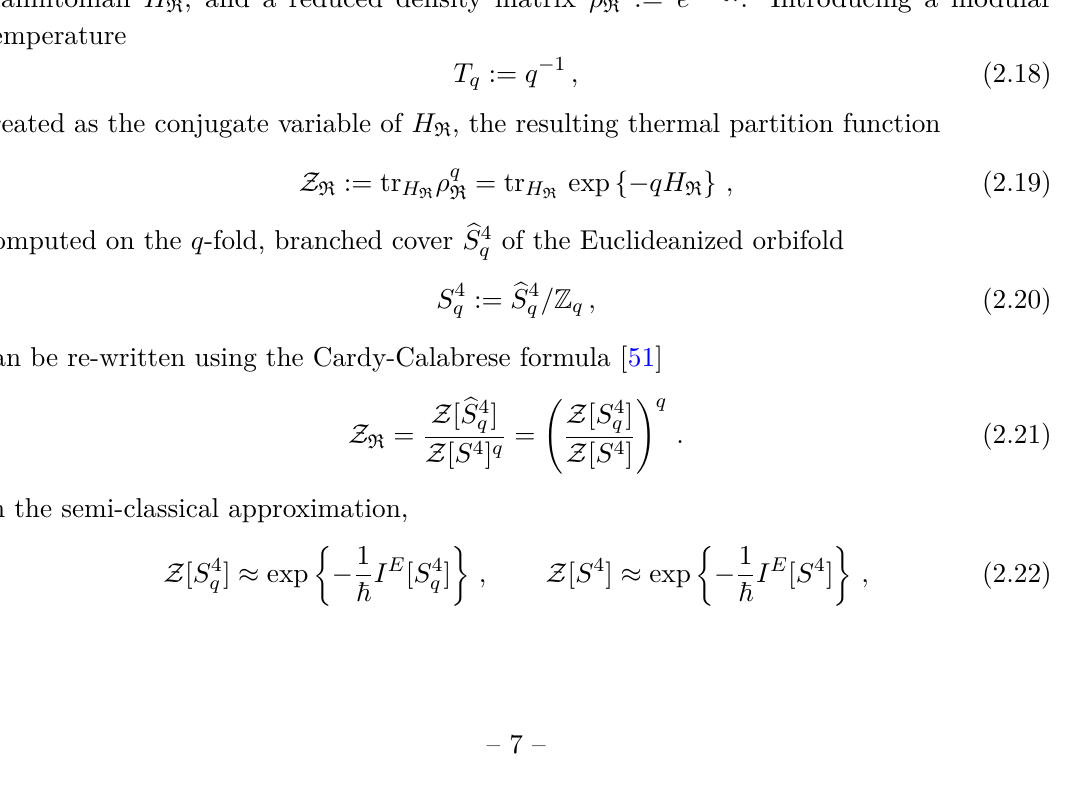
and Σ correspond to N S